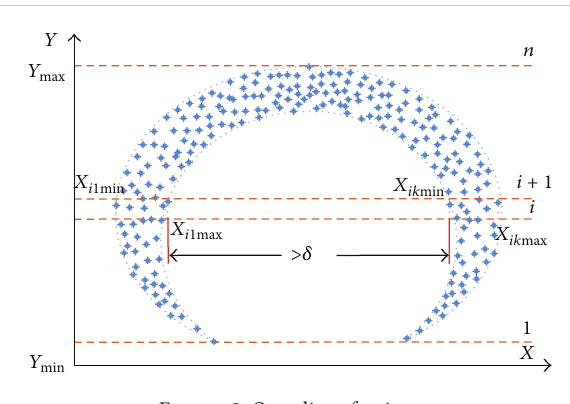
Figure 8: One slice of